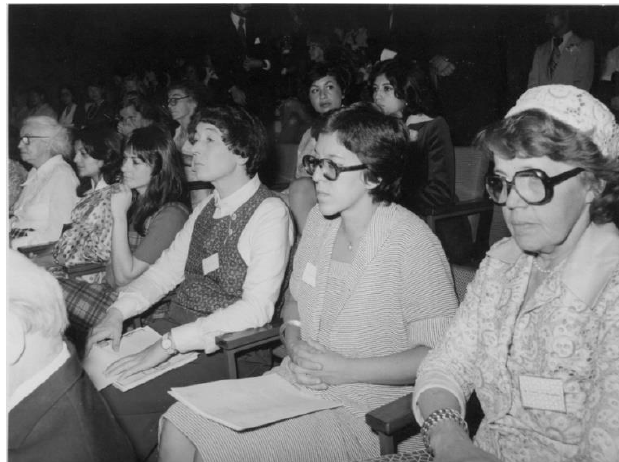
Figure 4. Anna Bofill Levi in attendance with other participants at the fourth UIFA congress, held in Ramsar, Iran in 1976. Image used with permission.